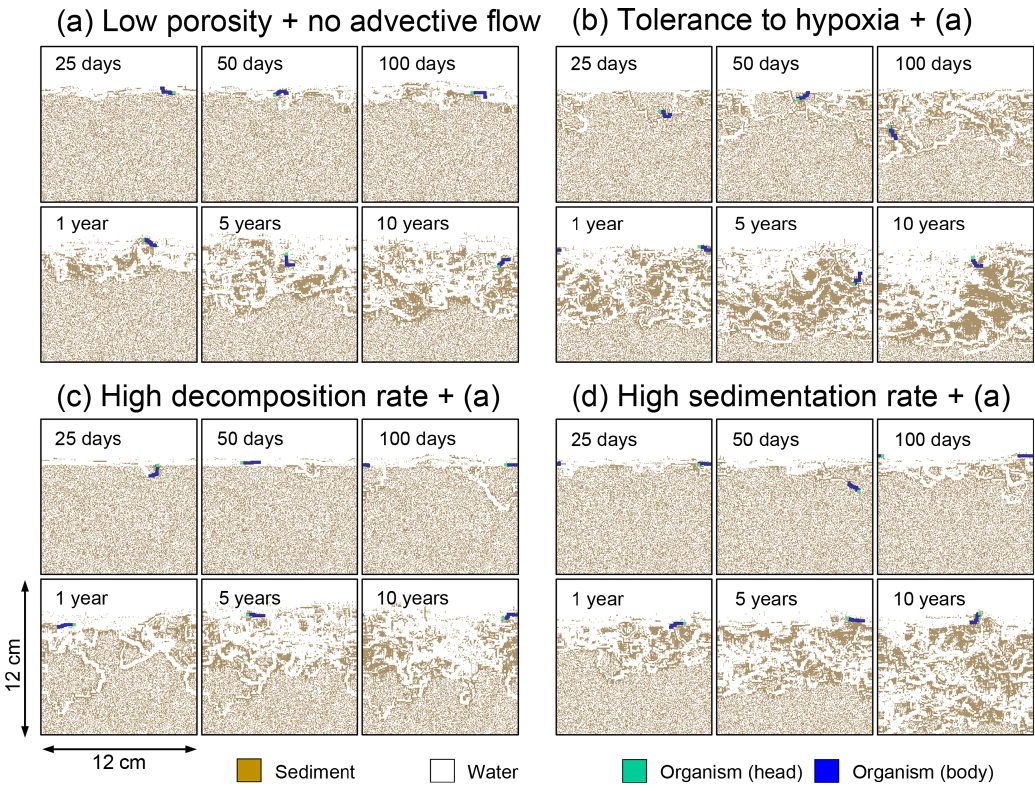
Figure 10. Time evolution of burrow geometry obtained from 10-year simulations with eLABS. See Sect. 3.2 and caption of Fig. 8 for the details of simulations (a–d) . Shown are burrow geometries at 25, 50, and 100 model days and 1, 5, and 10 model years from the start of the